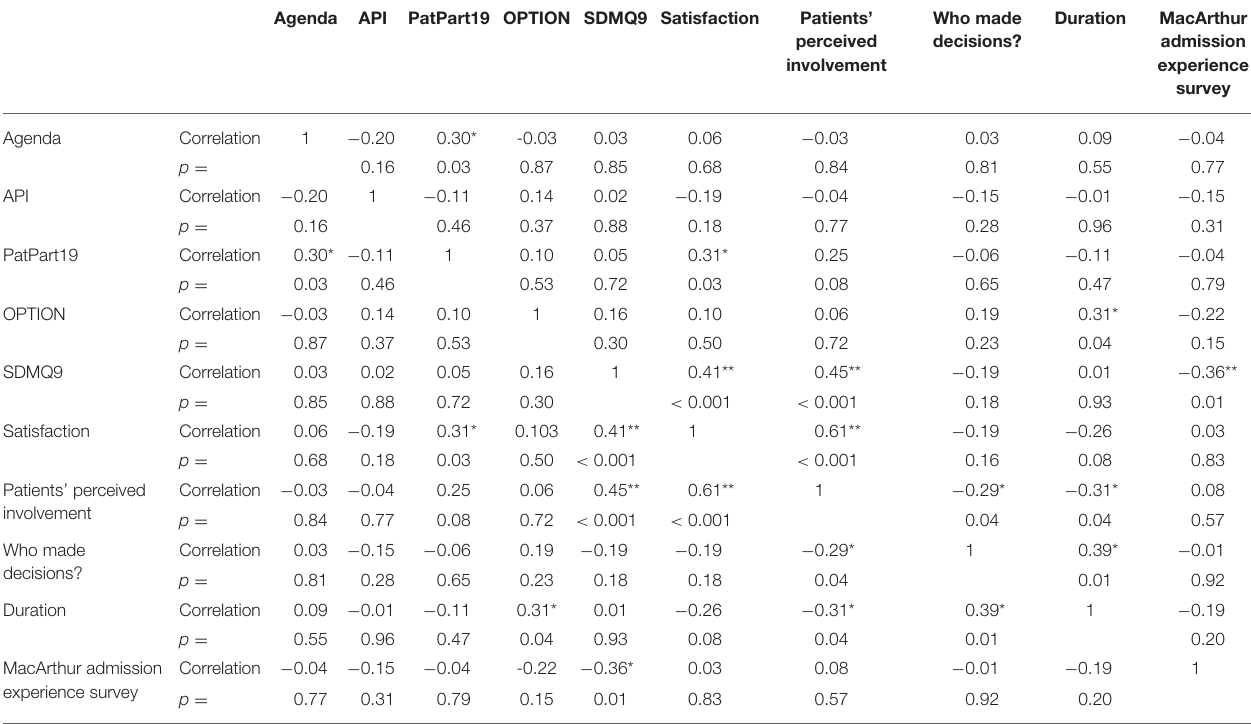
TABLE 4 | Correlation between different aspects of decision